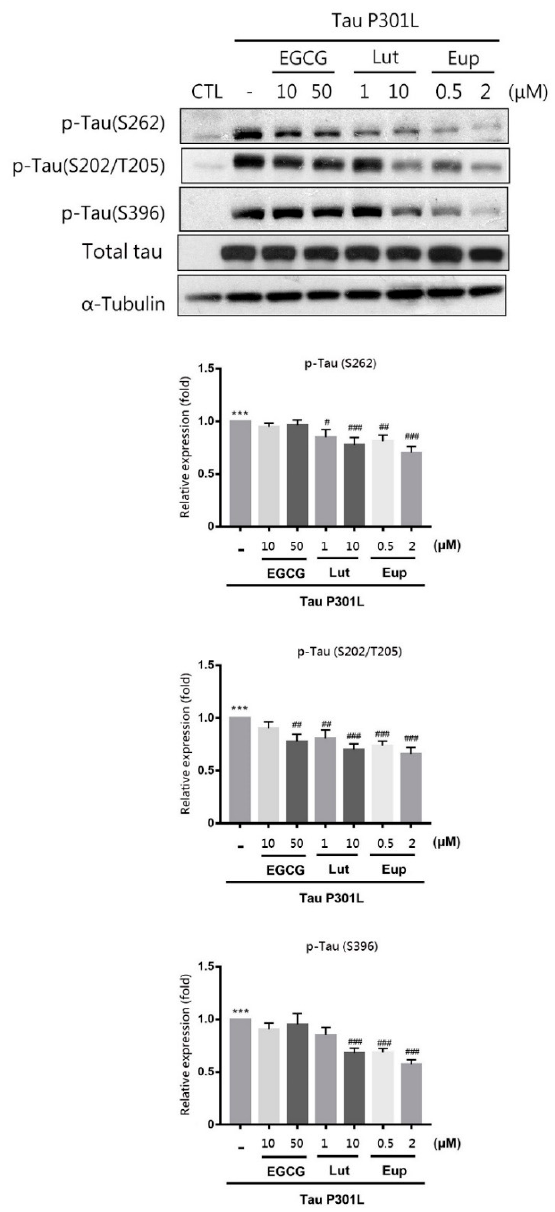
Figure 5. Eupatin achieved significant inhibition of tau phosphorylation. Neuro-2a cells underwent 24-h transfection using pRK5-EGFP-Tau P301L plasmid and were subsequently incubated with or without the indicated concentrations of EGCG, luteolin, or eupatin for 24 h. Western blotting of cell